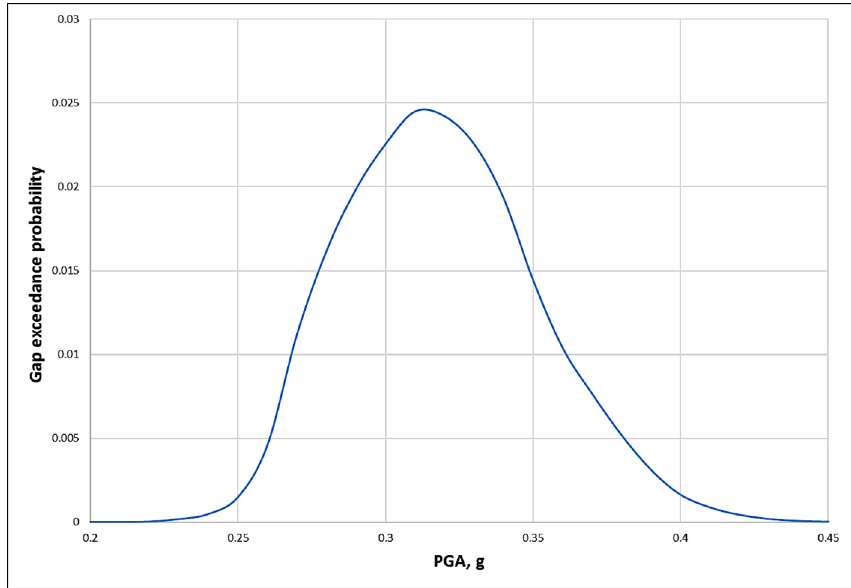
Figure 10. Exceedance probability distribution function of the gap versus peak ground acceleration.